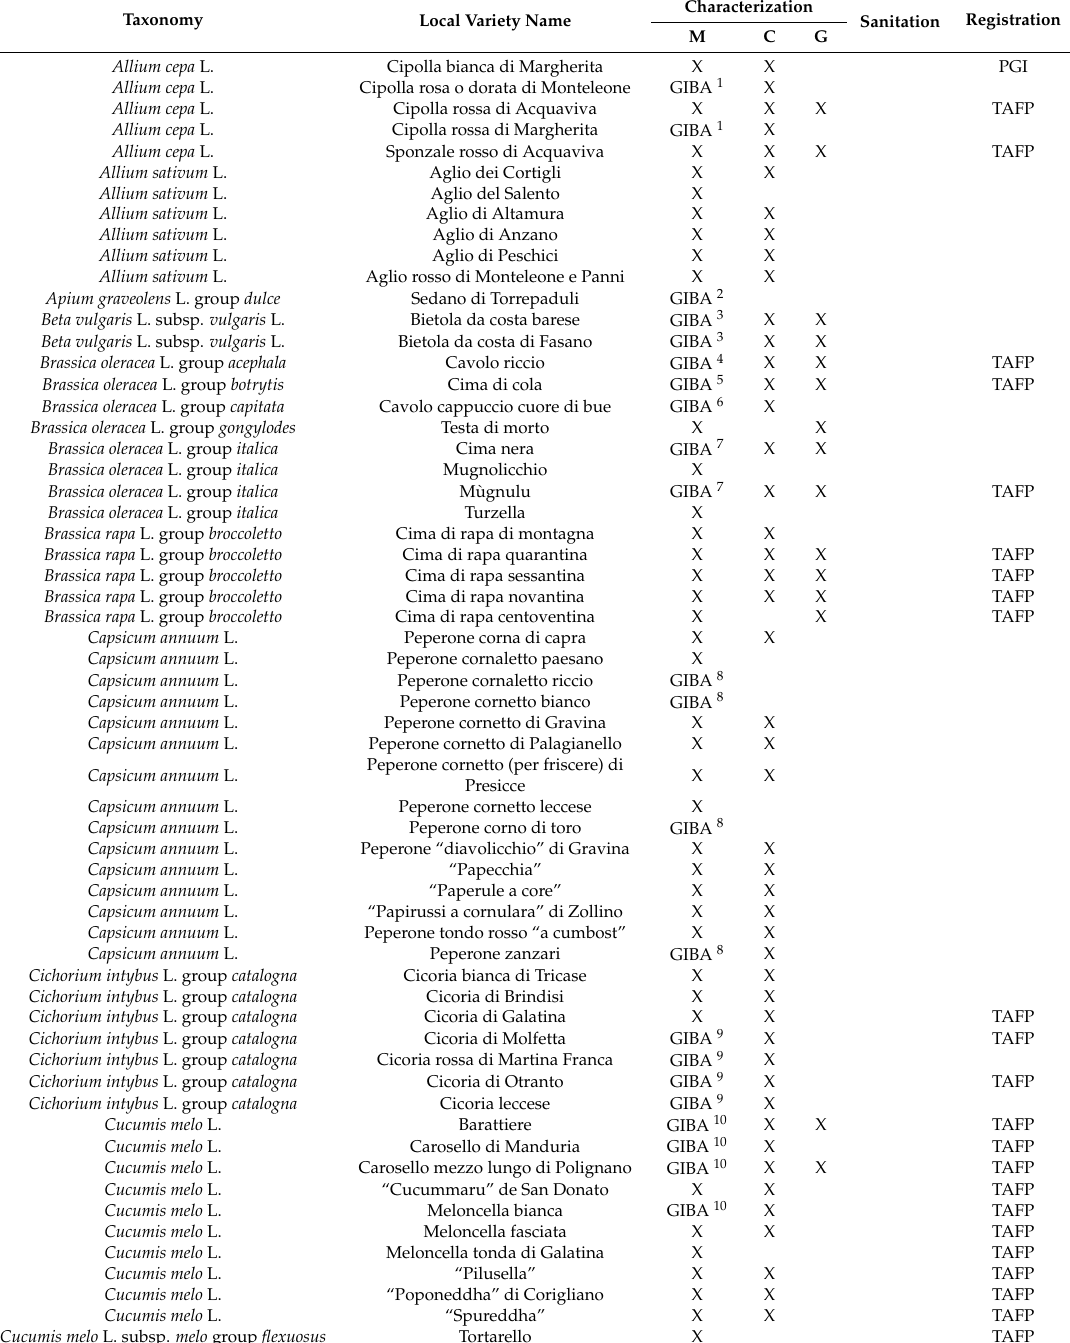
Table 1. Genetic resources studied during the project activity (adapted from Accogli et al. [11]). For each one, performed activities are indicated by using X symbol or a specific acronym. Registration column reports the state of art regarding Puglia local varieties with Protected Geographical Indication or registered as an item in the List of “Traditional Agri-Food Products” of the Italian Department for